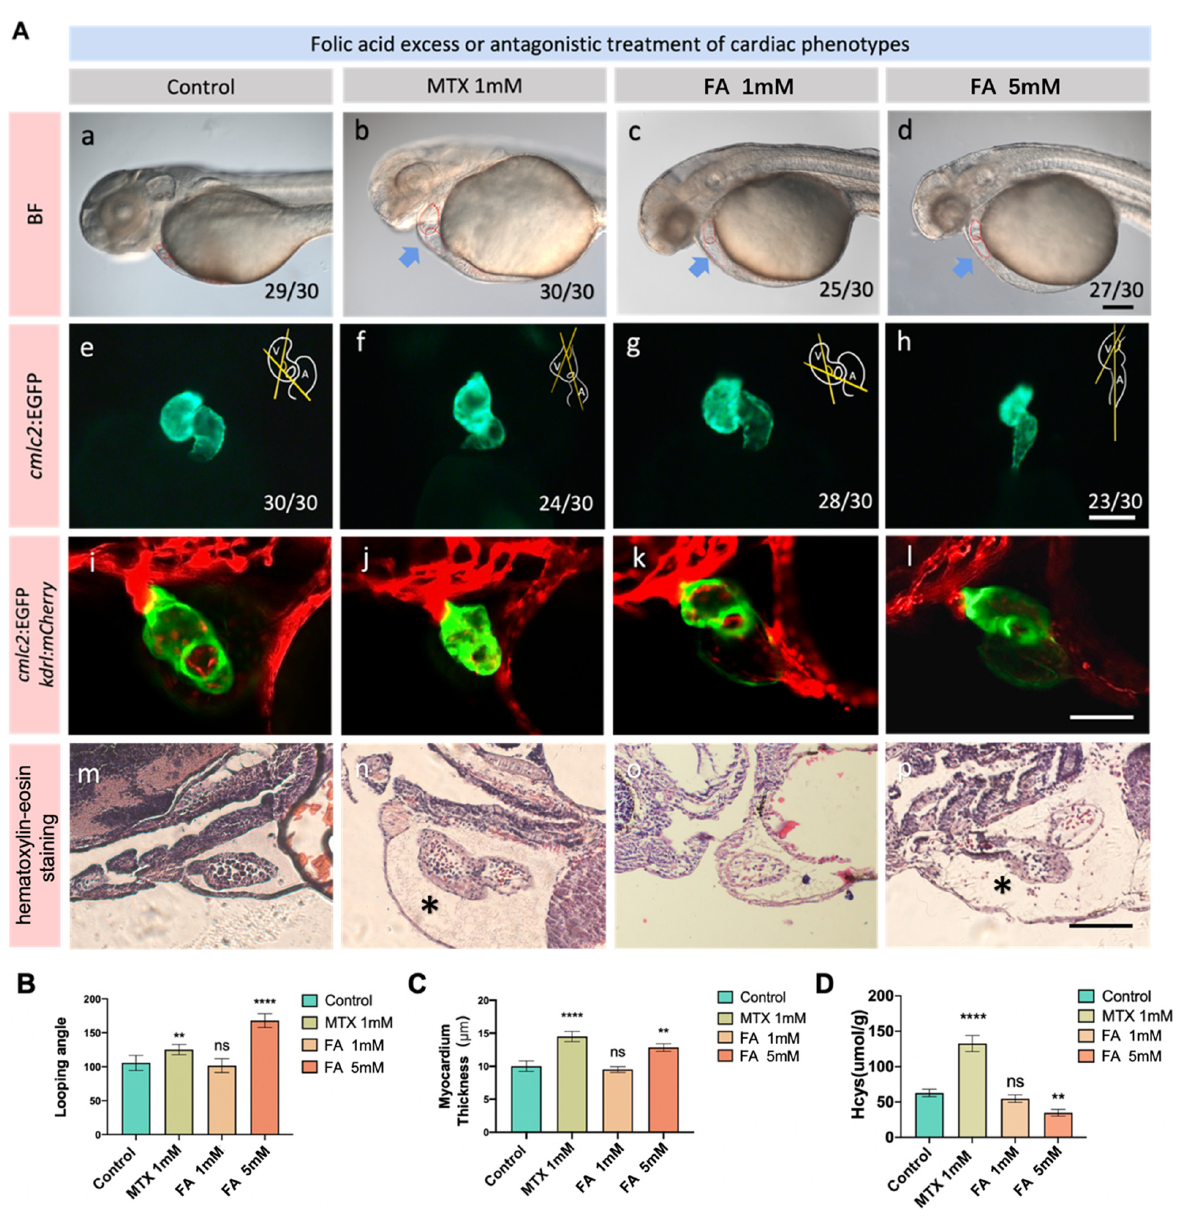
Figure 2. Folate excess and deficiency lead to different degrees of abnormal cardiac physiological function and abnormal metabolism of homocysteine. ( A ) The phenotypes of zebrafish embryonic heart treated with different concentrations of folic acid and MTX inhibited folate metabolism pathway were demonstrated at 3 dpf. ( a – d ) is the view under light microscope, ( e – h ) is cmlc2:EGFP labeled cardiac fluorescence images, ( i – l ) is cmlc2:EGFP and kdrl:mCherry Co labeled confocal images of the heart. ( m – p ) is images of a paraffin section of a zebrafish heart after staining by hematoxylin-eosin. Scale bars: 100 µ m. ( B ) Statistics on the influence of different folic acid treatment groups on the looping angle of zebrafish embryo heart. ( C ) Statistics on the influence of different folic acid treatment groups on the thickness of the ventricular myocardium of zebrafish embryos. ( D ) High homocysteine content in zebrafish of different groups. (Student t -test, * p < 0.05, ** p < 0.01, **** p < 0.0001, ns: no statistical